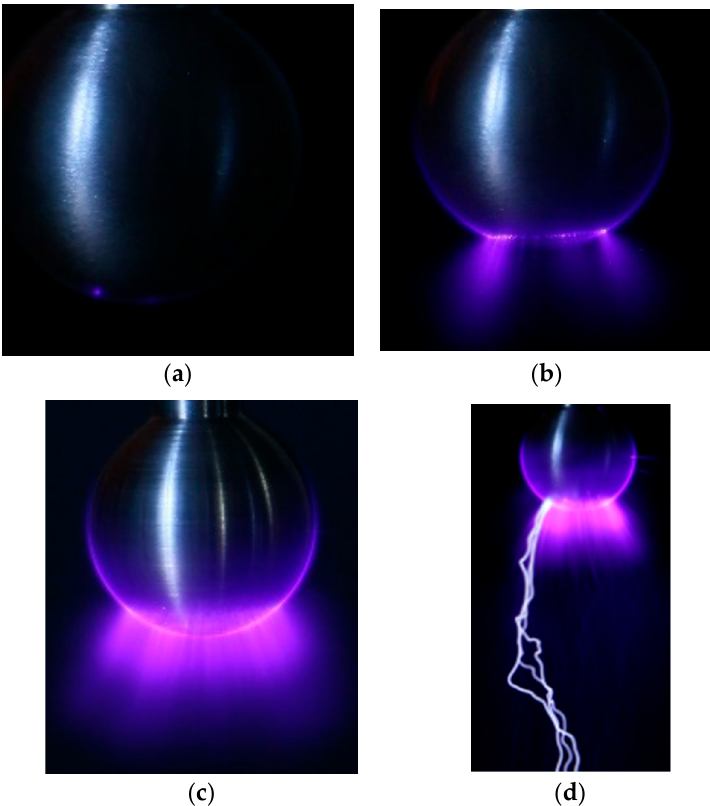
Figure 5. Alternating current corona (sphere diameter of 20 mm, h = 25 cm). ( a ) Initial corona at 59.0 kV peak ; ( b ) Corona glow (positive semi-period corona) and moving streamers (negative semi-period corona) condition at 65.5 kV peak ; ( c ) Advanced corona combining corona glow and multitude of moving streamers at 75 kV peak ; ( d ) Spark breakdown at approximately 139 kV peak .